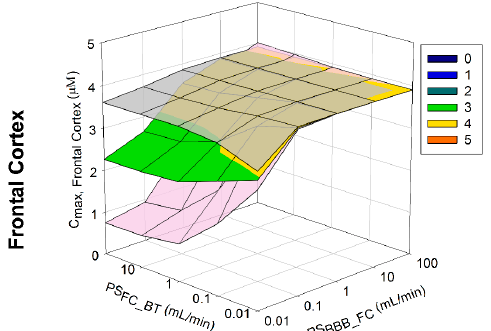
Figure 7. Model sensitivity analysis of brain PS on C max. Sensitivity analysis of the impact of variation in PS on the hippocampus (upper panel) or frontal cortex (lower panel) phenytoin C max . Gray mesh indicates profiles where PS BBB_BT is 10-fold lower and pink mesh indicates profiles where PS BBB_BT is 10-fold higher than that presented in the associated multicolor mesh plots. PS: permeability surface area product; HC_BT (hippocampus and brain tissue); BBB_HC (cerebral microvasculature [blood brain barrier] and hippocampus); FC_BT (frontal cortex and brain tissue) and BBB_FC (cerebral microvasculature [blood brain barrier] and frontal cortex).